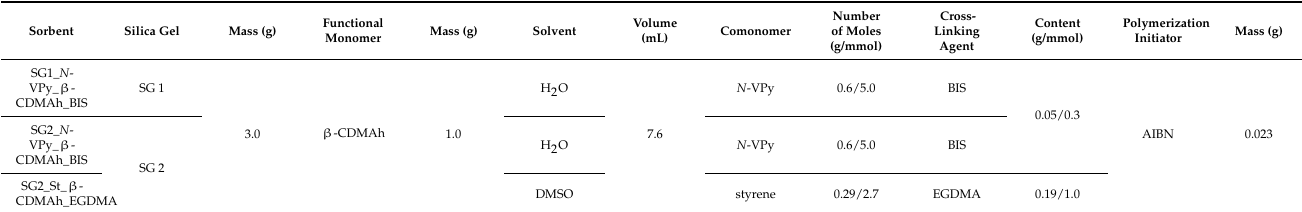
Table 2. Detailed conditions for the sorbent